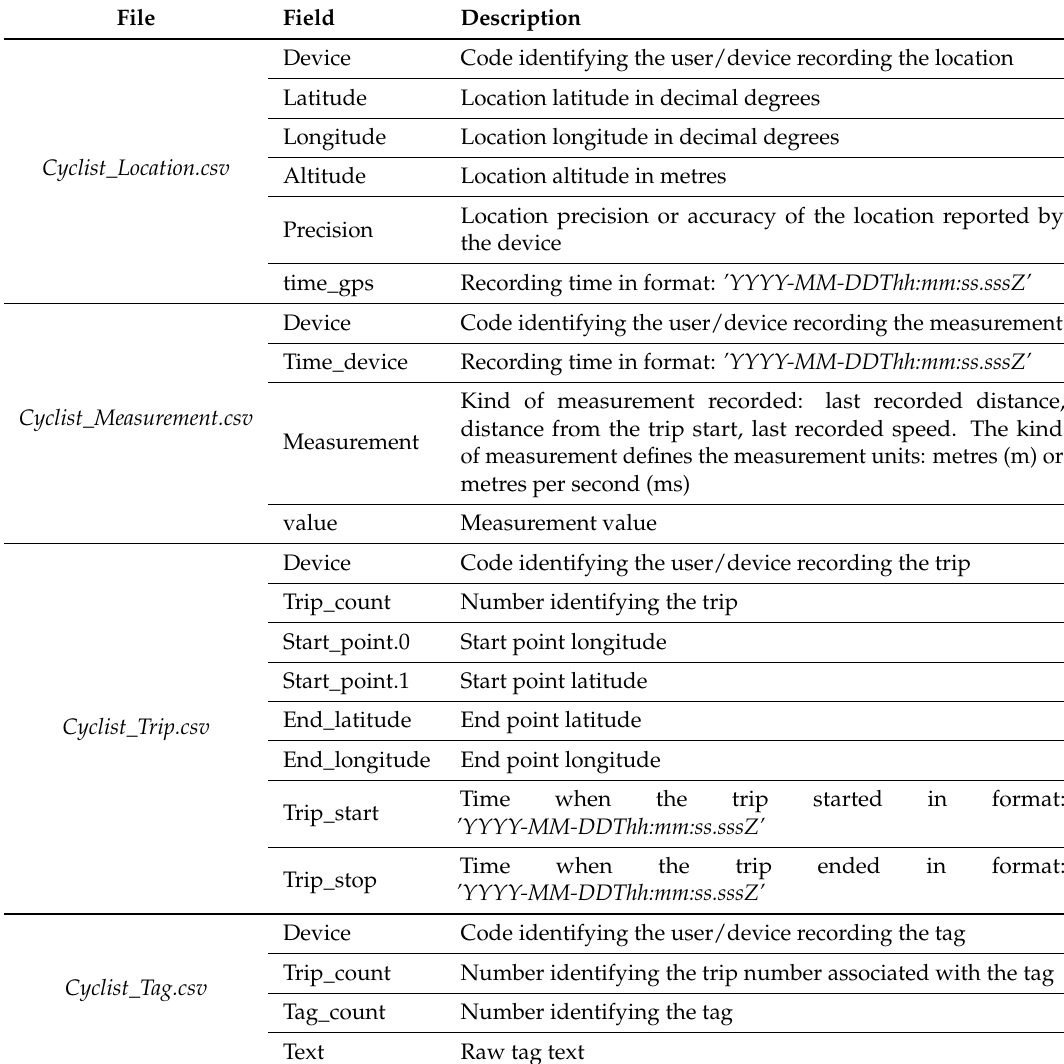
Table A1. Description of the datasets used for the